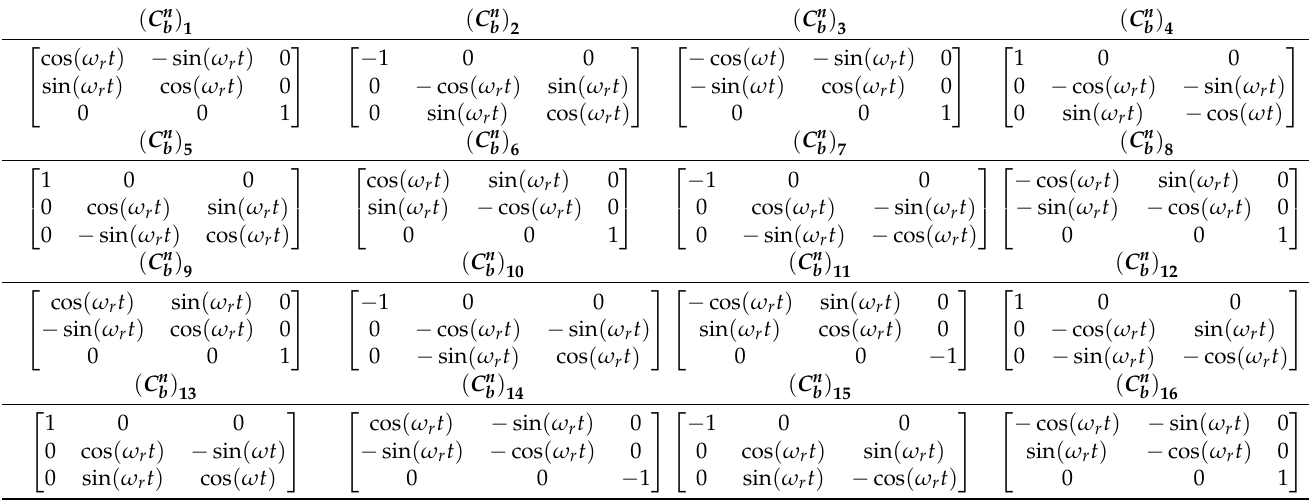
Table 2. Direction cosine matrix for the 16-position rotation